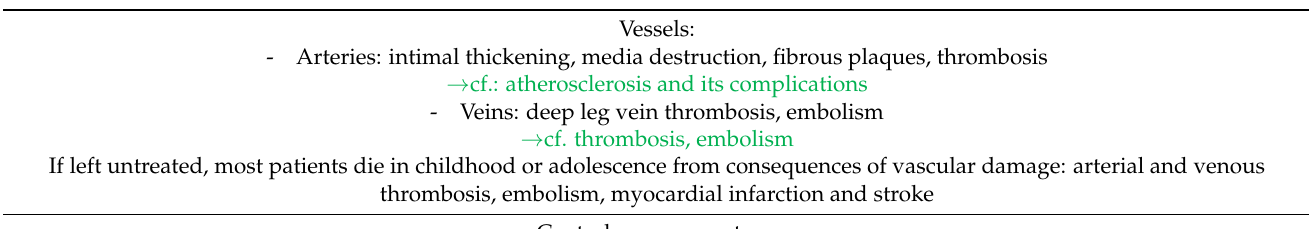
Table 2. Clinical symptoms associated with a homozygous CBS defect in analogy to common HHCys-related dis- eases (green).